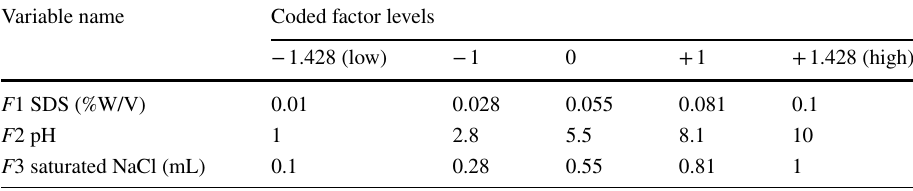
Table 1 Variables and values used for central composite design